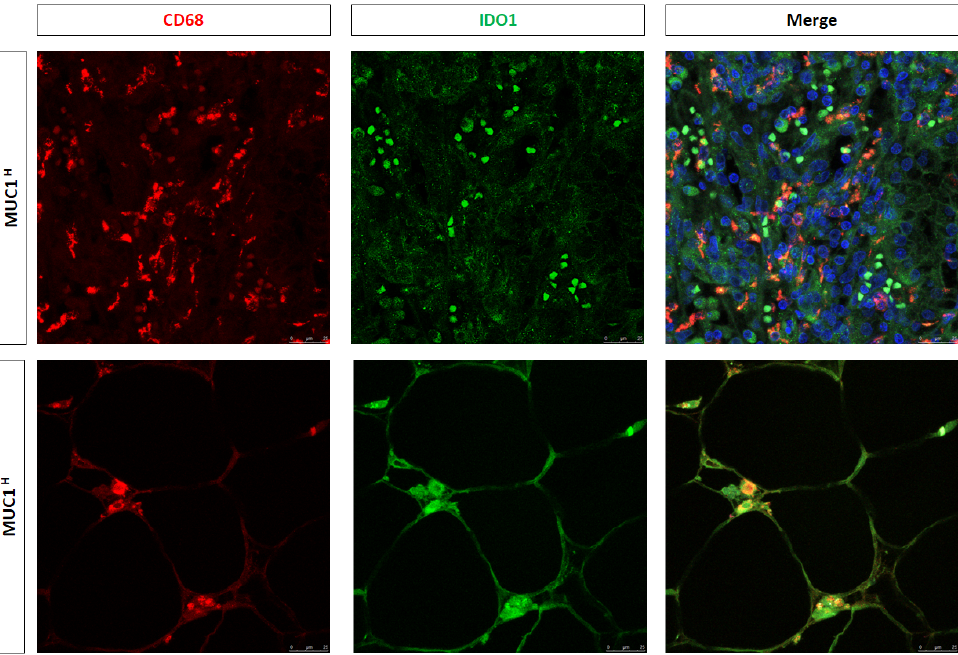
Figure 10. Expression of CD68 and IDO1 and their colocalization in neoplastic renal tissues from MUC1 H ccRCC and MUC1 L tumors.